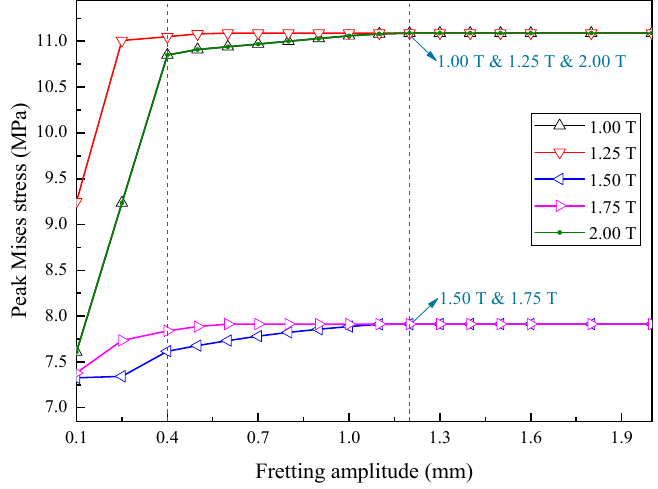
Figure 6. Relationship between peak Mises stress and A f during 1–2 T. When the fretting displacement is less than 0.4 mm, the fretting runs in the sticking region. To further clarify the influence of A f on the fretting characteristics of the X-ring, it is urgent to compare the fretting periodicity of the X-ring running in the sticking and gross slip regions. The X-ring’s change of the peak contact pressure and the peak Mises stress (collectively referred to as “peak stress”) during 0–3 T are investigated when A f is 0.2 mm, as shown in Figure 7. At 0.75 T, the peak stress of the X-ring begins to change periodically with a period of 1 T. During each fretting period, taking 0.75–1.75 T as an example, the peak stress values of adjacent locations are different, which further verifies that the X-ring runs in the sticking region when the A f is 0.2 mm.